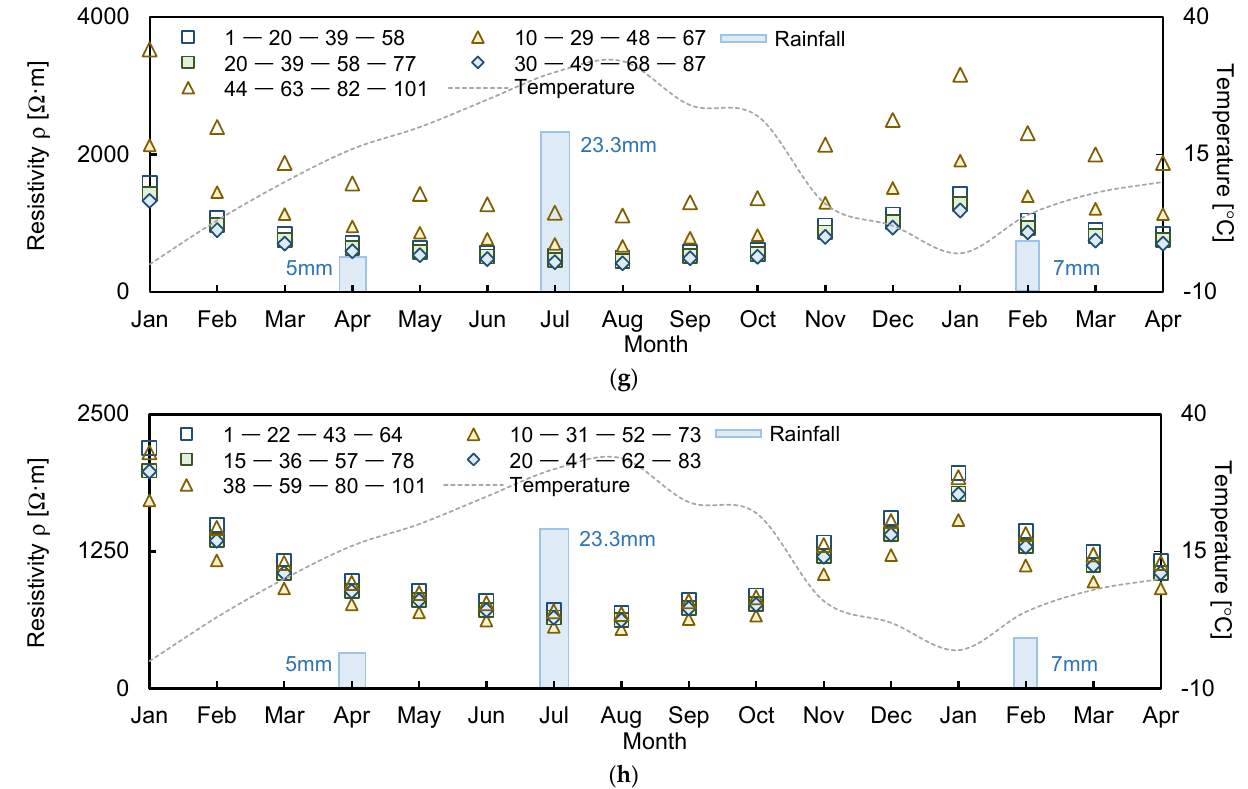
Figure 3. Distribution of measured electrical resistivity using electrode spacings of: ( a ) 1; ( b ) 4; ( c ) 7; ( d ) 10; (e ) 13; ( f ) 16; ( g ) 19; ( h ) 21.